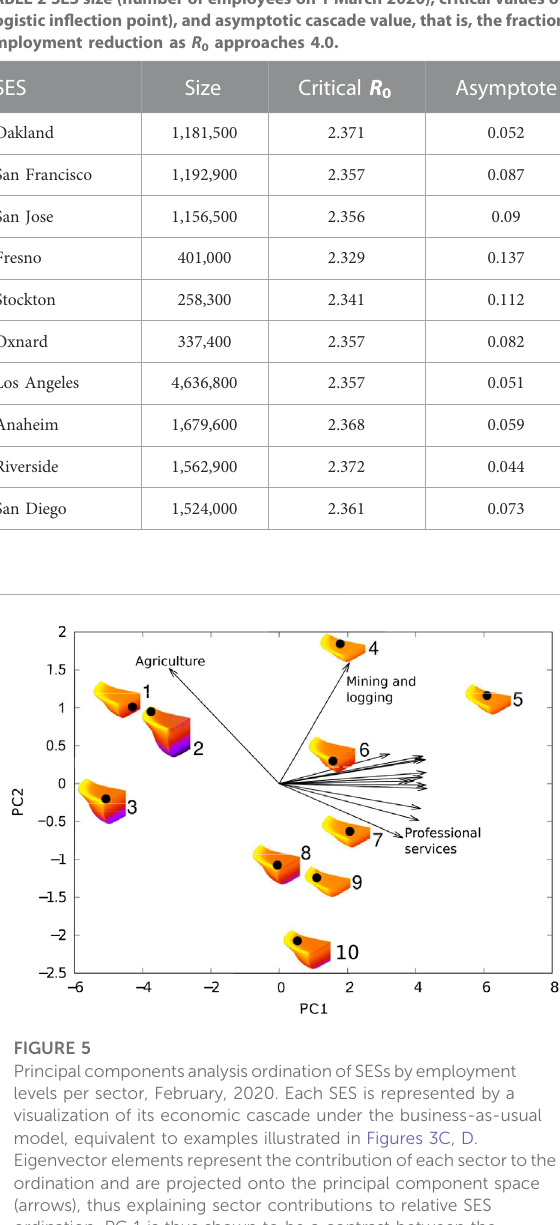
generates the largest change in the economic cascade. SES mid- points are signi fi cantly correlated with the logarithm of system size (Pearson ’ s correlation, r 2 = 0.728, p = 0.017) and range from 2.33 to 2.37, with larger SESs having higher thresholds of R 0 (Table 2; Figure 4B) below which the cascading effects of outbreaks are relatively smaller. R 0 of 2.3 – 2.4 is therefore an economically critical threshold range, or tipping points, for outbreak intensity for the California SESs.